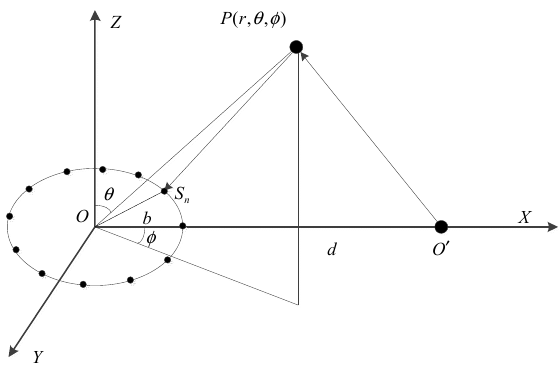
Figure 1. The radar geometry.